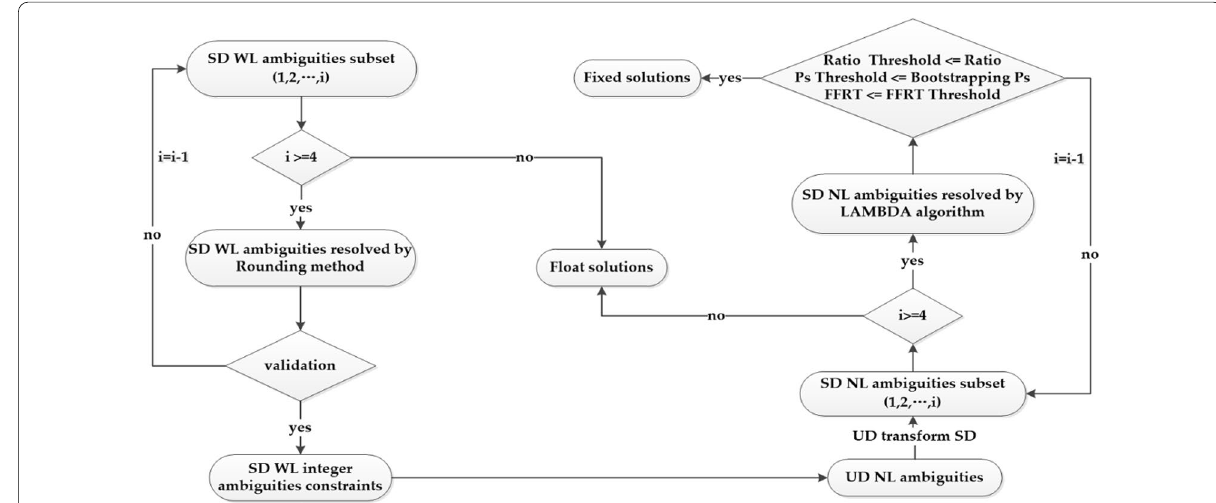
Fig. 1 Flowchart of two-step partial UCPPP